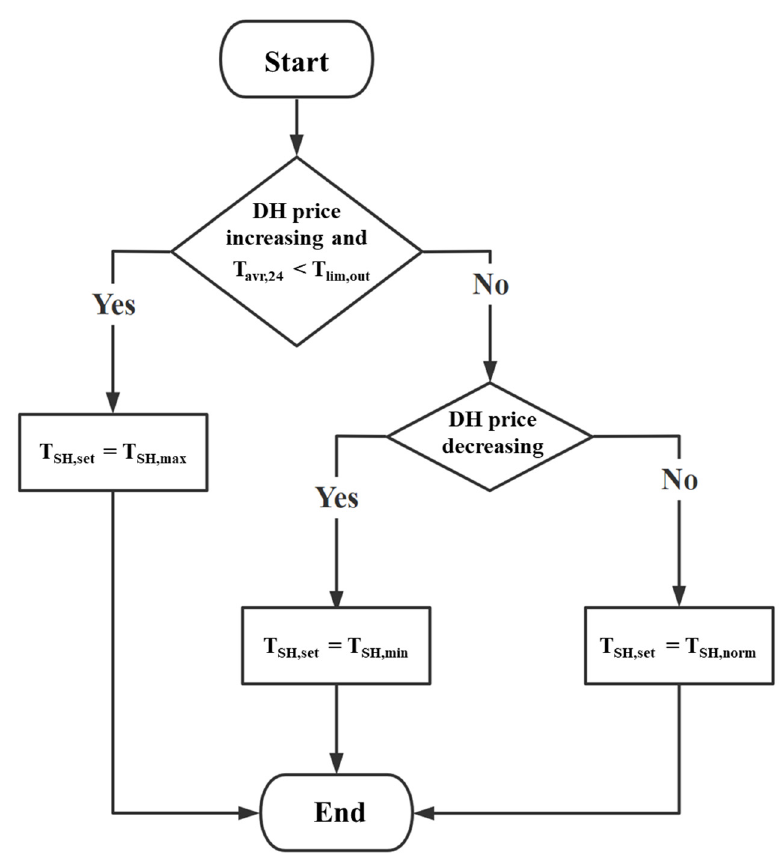
Figure 5. Decentralized DR control of space heating.